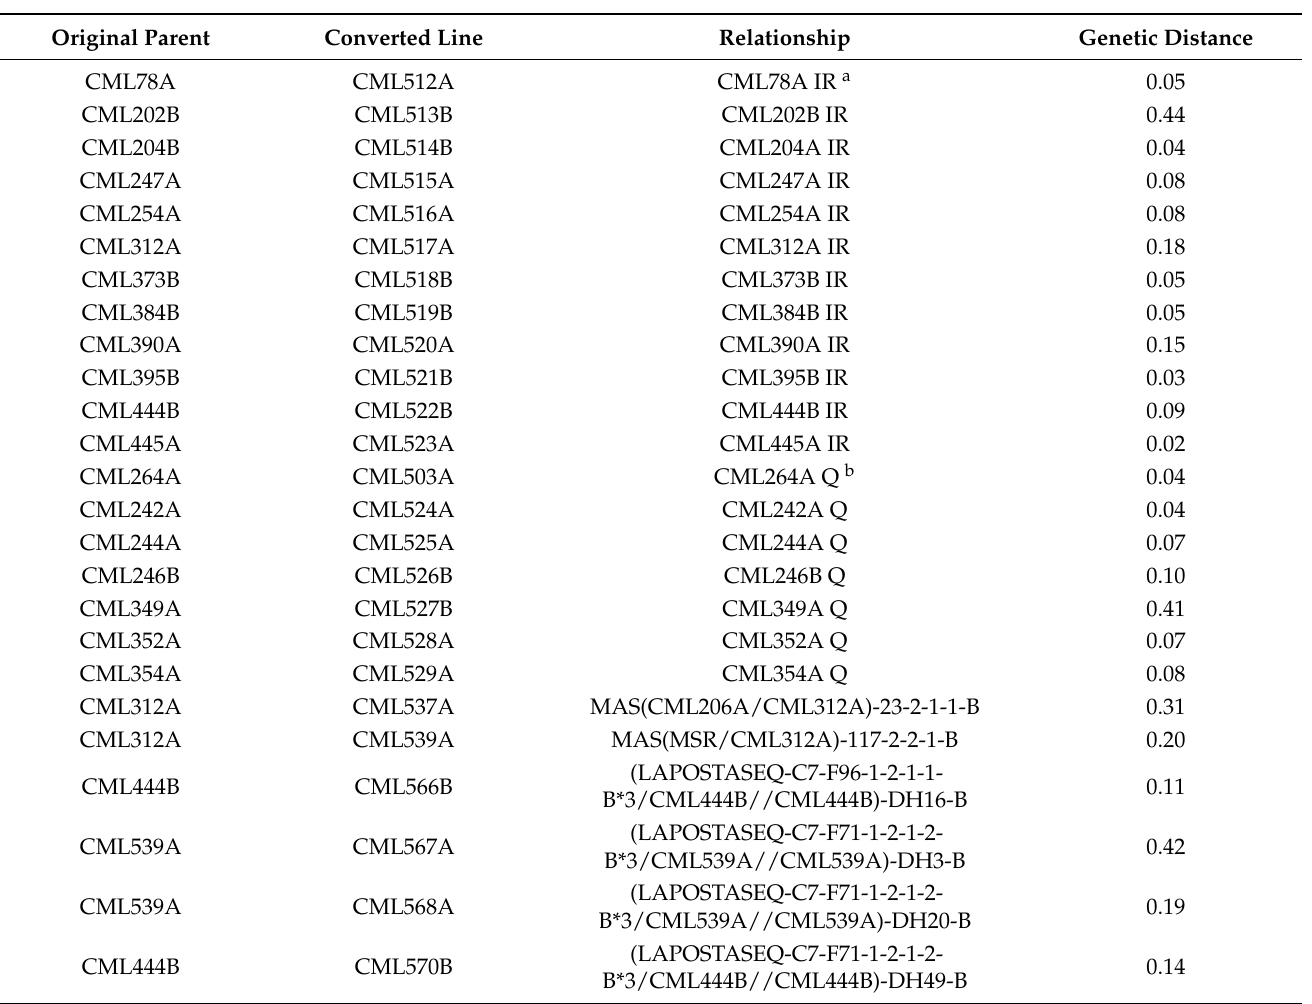
Table 2. The genetic distance between the original parent and the converted line.